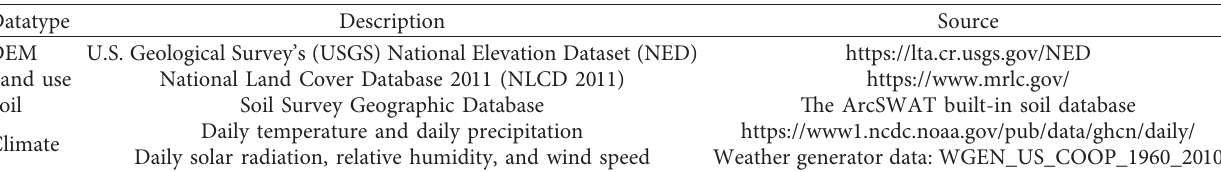
Table 2: Data source and description of the SWAT